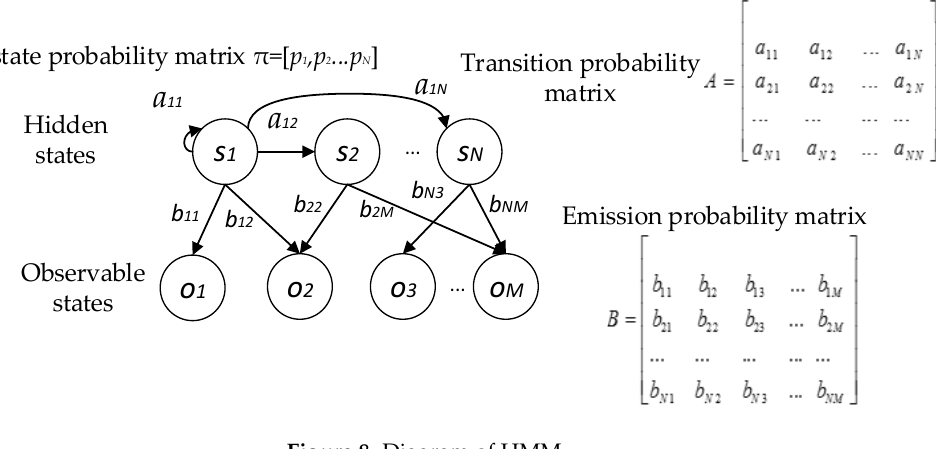
Figure 8. Diagram of HMM.